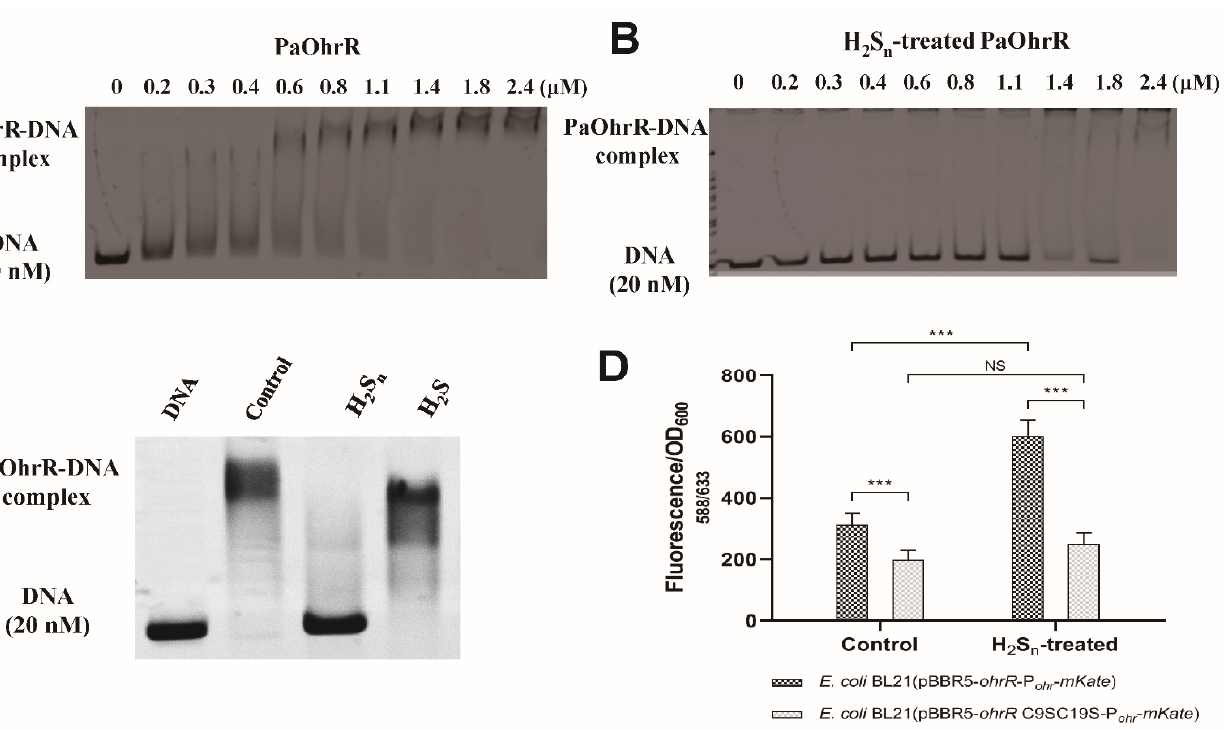
Figure 1. PaOhrR sensed sulfane sulfur in vitro and in vivo. ( A , B ) EMSA analysis of the binding of H 2 S n -treated and untreated PaOhrR to its DNA probe. Different amount of the treated and untreated PaOhrR was incubated with 20 nM the DNA probe for EMSA. ( C ) H 2 S did not affect PaOhrR binding to its DNA probe. A total of 1.2 µ M H 2 S n -treated PaOhrR, H 2 S-treated PaOhrR, or untreated PaOhrR (control) was incubated with 20 nM the DNA probe for EMSA. The control was the untreated PaOhrR. ( D ) E. coli BL21 containing pBBR5-OhrR-P ohr -mKate and E. coli BL21 containing pBBR5-OhrR (C9SC19S)-P ohr -mKate were induced at OD 600nm of 2 with 600 µ M H 2 S n for 2 h. Symbol *** indicates the sample is significantly different from the control ( p < 0.001). NS = ( p >